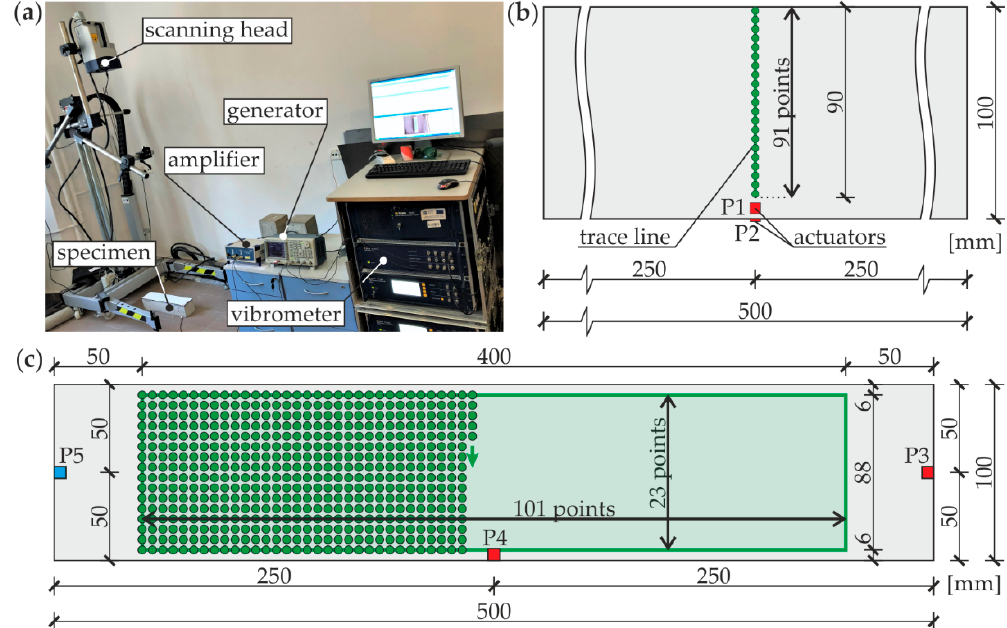
Figure 3. Experimental investigations: ( a ) setup for scanning laser Doppler vibrometry (SLDV) measurements; ( b ) scheme of measurements for dispersion curves determination; and ( c ) scheme for damage identification and visualization measurements.